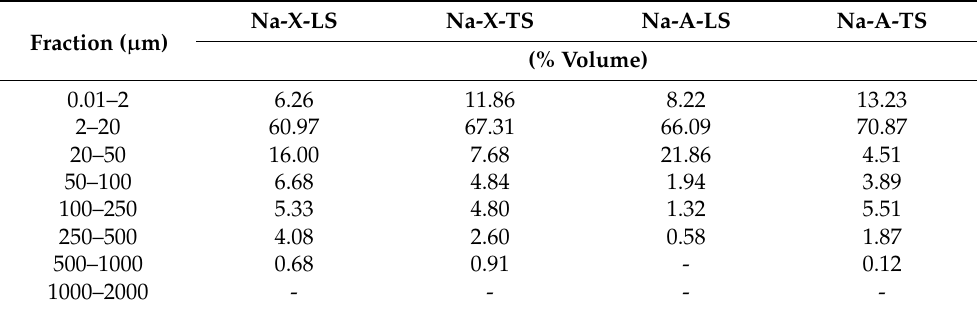
Table 2. Percentage distribution of individual grain fractions ( µ m) of studied zeolites Fraction ( µ m)